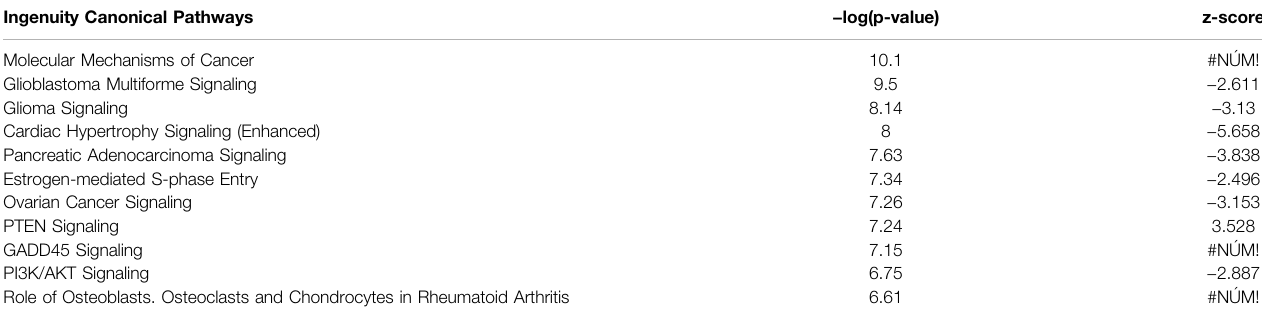
TABLE 3| Top canonical pathways as predicted targets for aging-induced miRNAs content changesin circulating adipocyte-derived EVPs from aged animals compared to young adult ( − log (p-value) ≥ 3; z-score ≥ 2 or ≤ − 2). Ingenuity Canonical